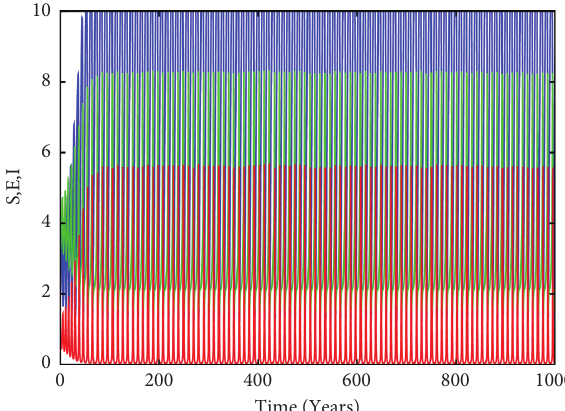
Figure 4: The oscillatory simulation of susceptible individuals (blue colour), exposed individuals (green colour), and infected individuals (red colour). Parameters are β � 1 . 7, Λ � 4, μ � 0 . 18, δ � 0 . 08, κ � 0 . 03, p � 0 . 5, c � 0 . 02, and ϖ � 0 . 1 which give R C � 2 . 3670 > 1. The oscillatory solution is unstable for some initial conditions. Those used to produce the figure are S (0) � 2, E (0) � 3, and I (0) �